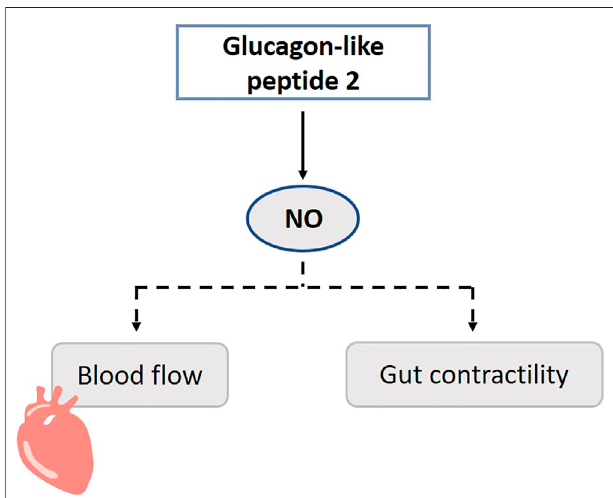
FIGURE 10 | Role of gasotransmitters on glucagon-like peptide 2 ’ s (GLP-2) physiological functions. Dotted lines represent fi rst evidence for the presence ofthe pathway. GLP-2promotes NO release, and thismay increase blood fl ow and contractility of the gut. NO, Nitric oxide.